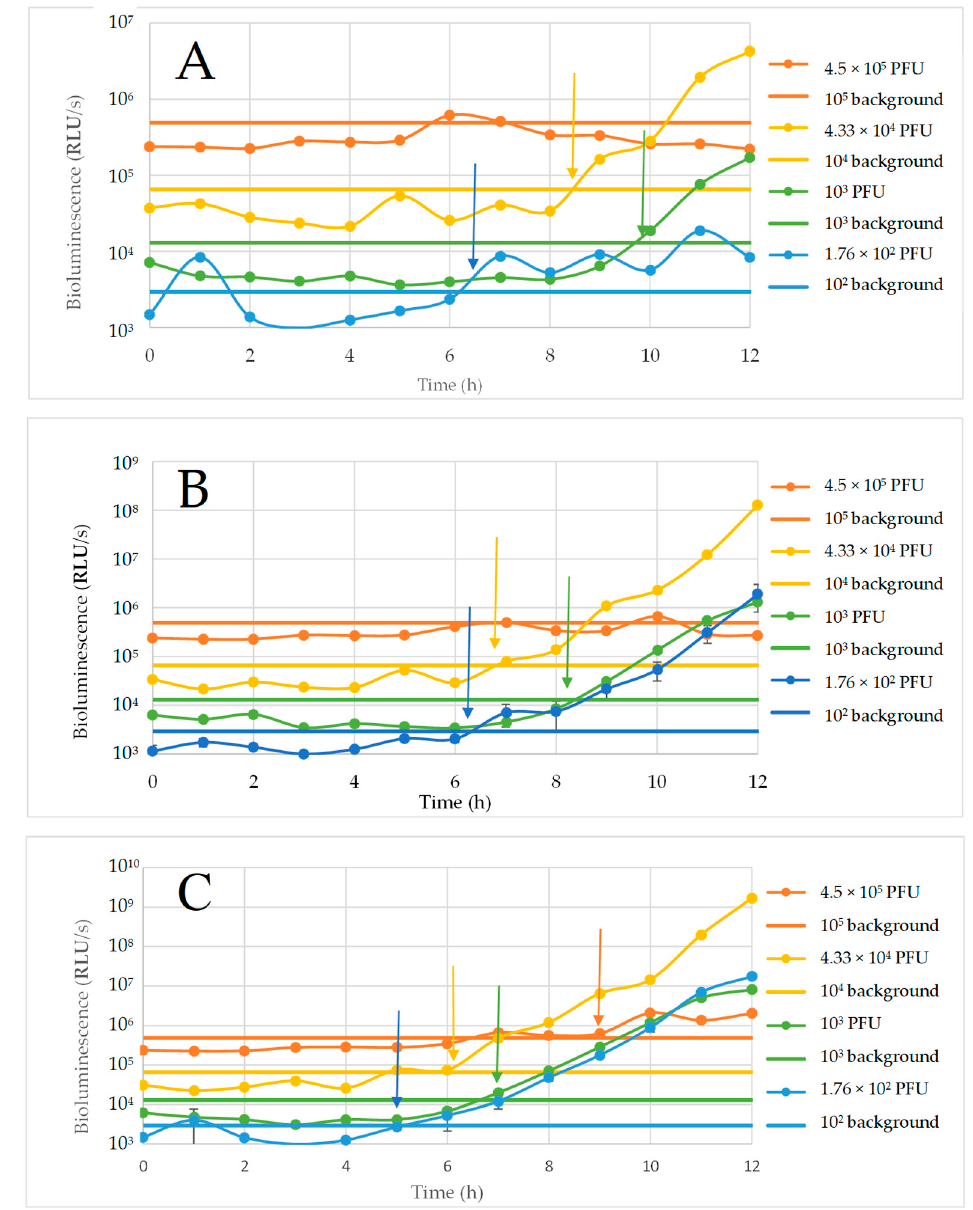
Figure 1. Detection of ( A ) 2 CFU, ( B ) 20 CFU, and ( C ) 200 CFU per sample using various amounts of the Φ V10 nluc phage. The arrows indicate the times when the luminescence of the sample increases above that of the cell-free controls.